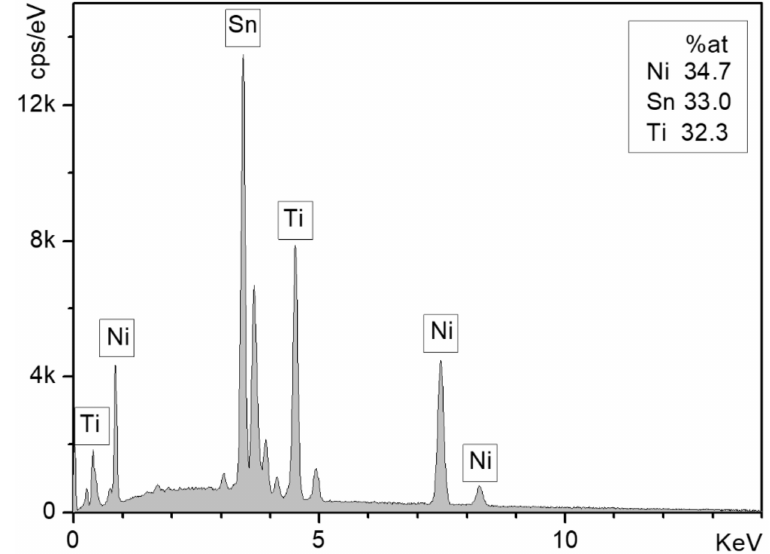
Figure 1. EDS spectrum of the sample